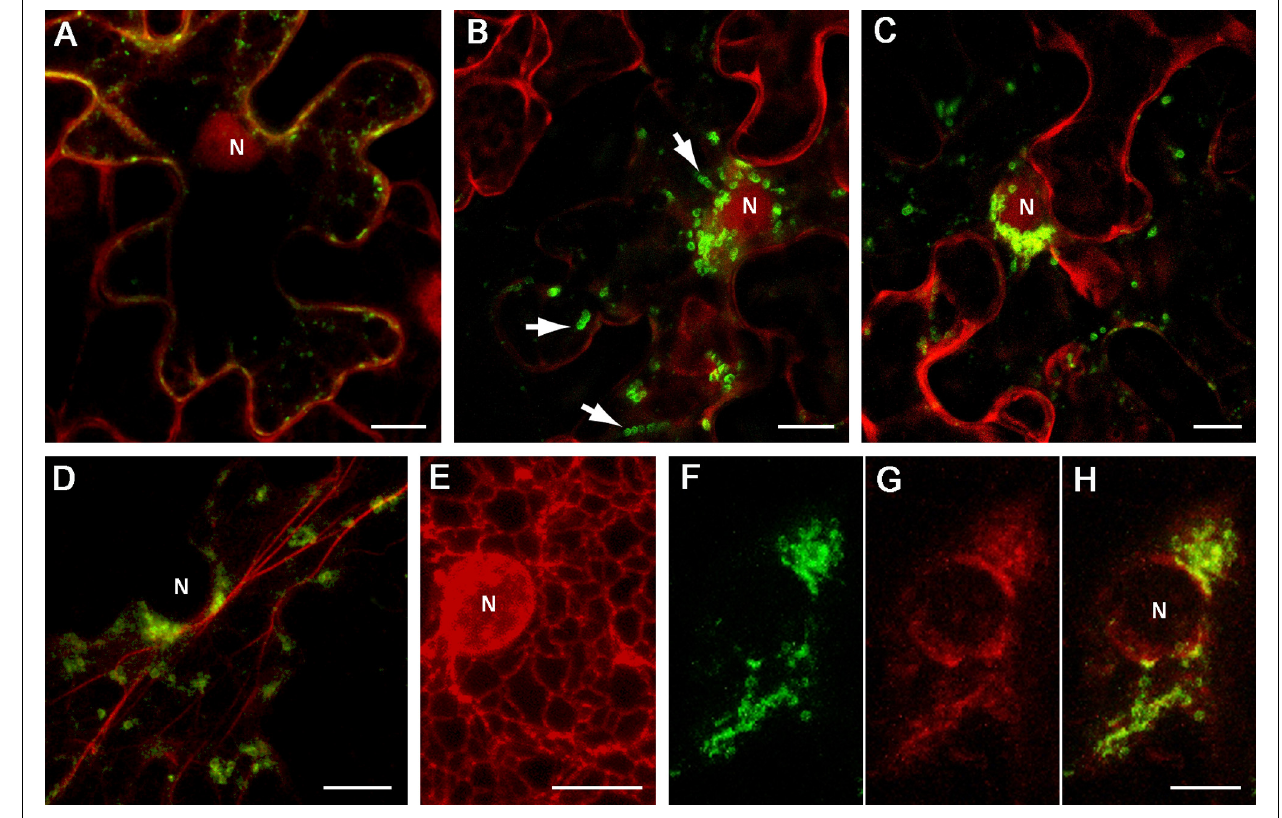
marker for actin cytoskeleton (Shemyakina etal., 2011). (E) Expression of ER-mRFP, the protein targeted to the ER lumen by N-terminal signal peptide and C-terminal ER-retention signal (Haseloff etal., 1997), in the perinuclear region of a plant cell. ( F–H ) Co-expression of GFP:CR-2 with ER-mRFP. (F) Perinuclear groups of GFP:CR-2-containing globules. (G) Modified perinuclear ER representing diffuse membrane reservoirs. (H) Overlap of images (F) and (G) . All images represent the superpositions of series of confocal optical sections. N, nucleus. Scale bar, 10 μ